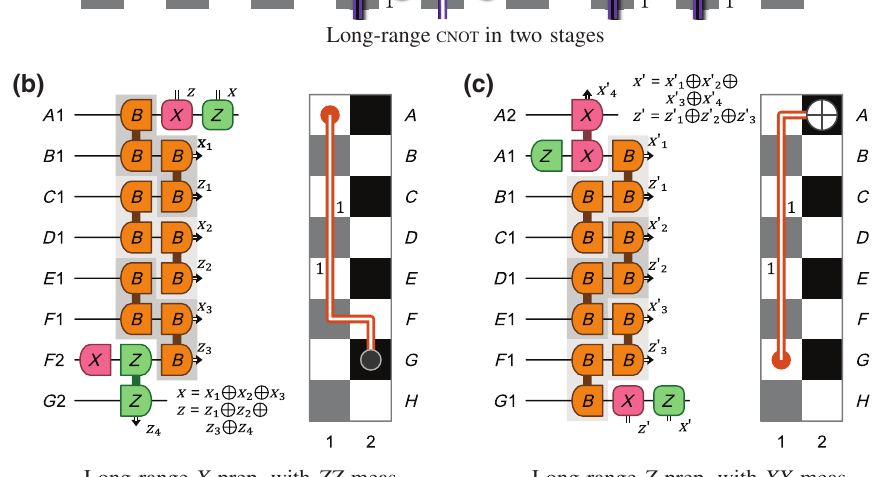
FIG. 9. Detailed implementation of the steps in Fig. 6. For each seg- ment that is scheduled in phase